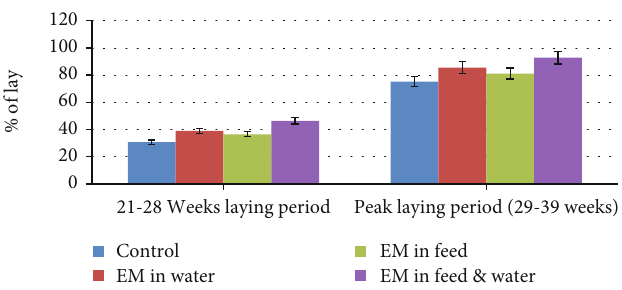
Figure 1: Average daily egg production of chickens in percent treated with EM in feed and water. Table 4: Daily egg production of chickens treated with EM in feed and